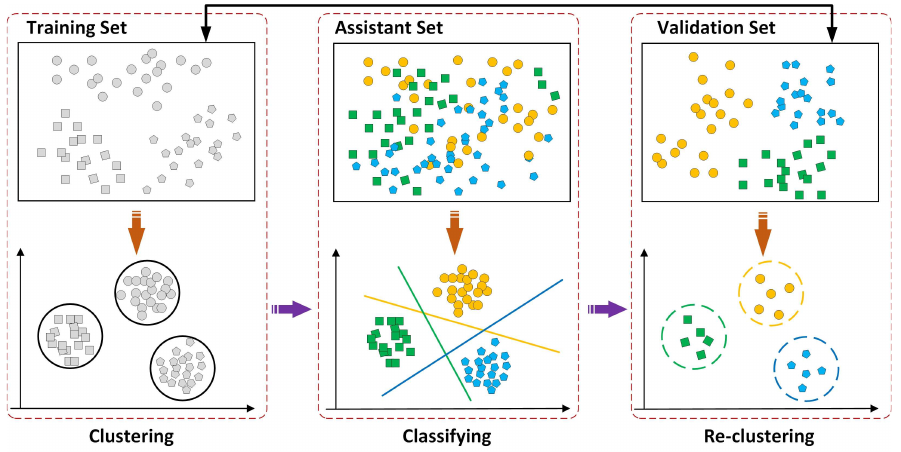
Figure 3. Framework of attribute learning. Attributes are learned by iteratively repeating clustering and classification